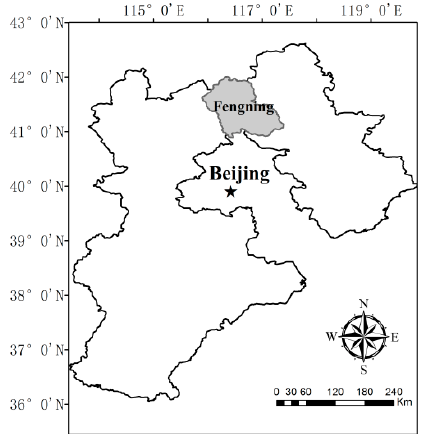
Figure 1. Location of the study area (denoted as the grey area). The black outlined area indicates this study area is located in Hebei Province, China.